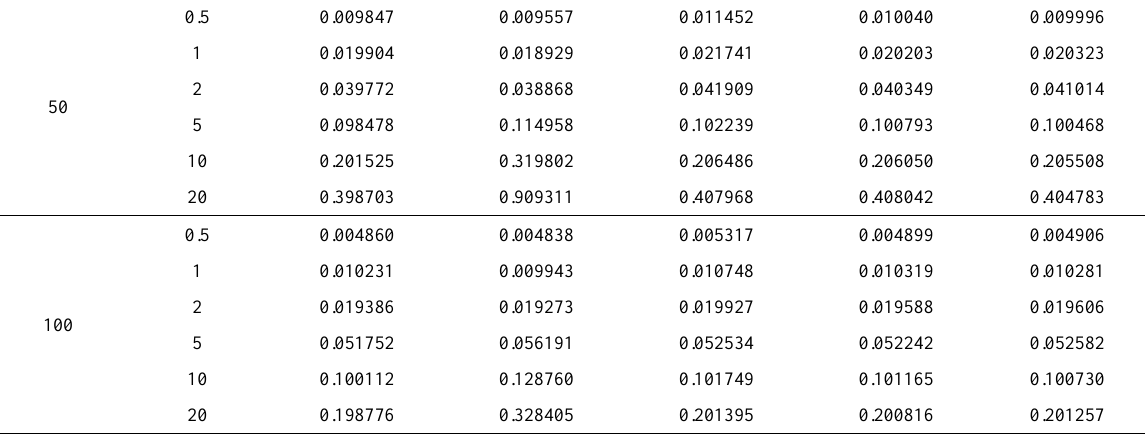
Table 2. MSE of different estimators of Poisson distribution when a =2, b